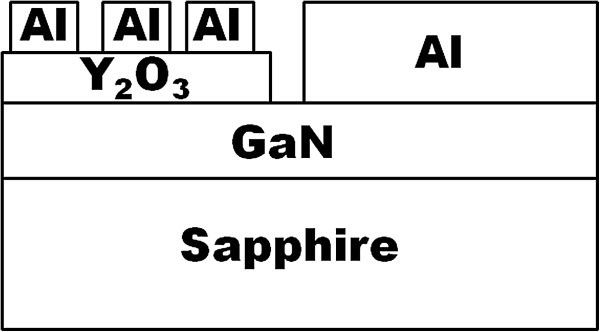
Al/Y2O3/GaN MOS test structure.